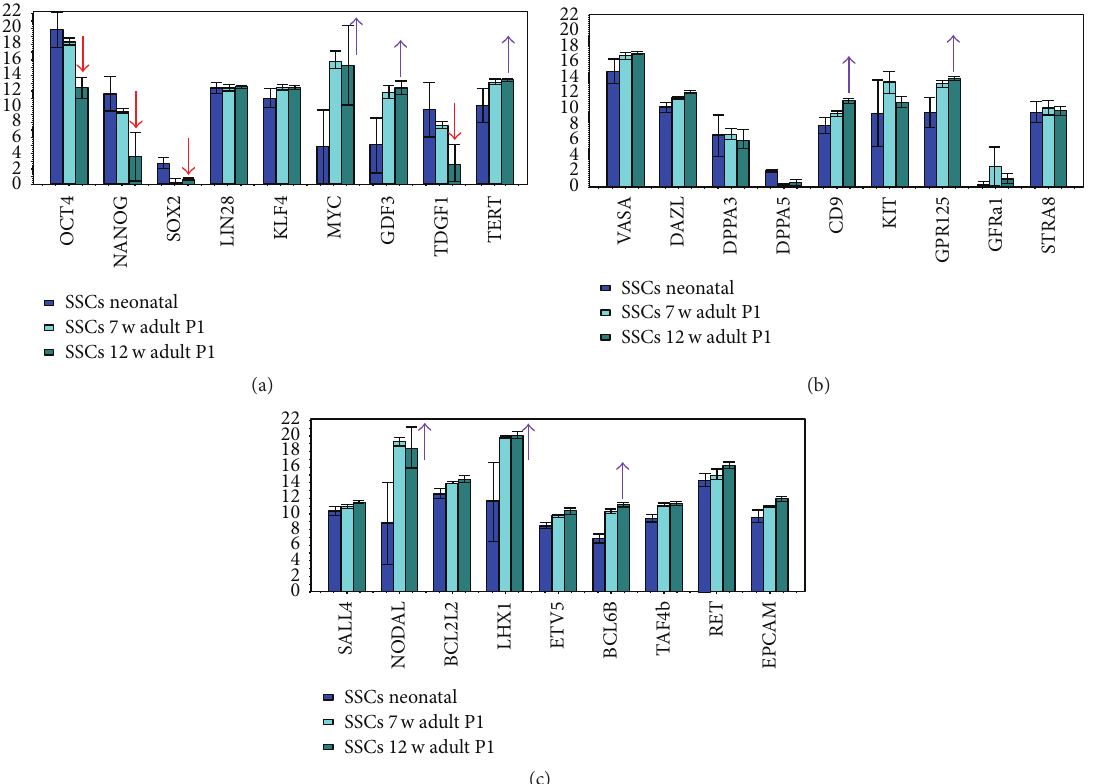
Figure 3: Bar plot showing expression of pluripotency and germ cell associated genes between neonatal SSCs (coloured dark blue), 7-week- old adult SSCs (coloured light blue), and 12-week-old adult SSCs (coloured green blue). Red arrows mark significantly downregulated genes and purple arrows mark upregulated genes in adult SSCs (more than 2-fold and 𝑃 < 0.05 ). Note that the core pluripotency genes Oct4, Nanog, and Sox2 are downregulated in adult SSCs from 12-week-old